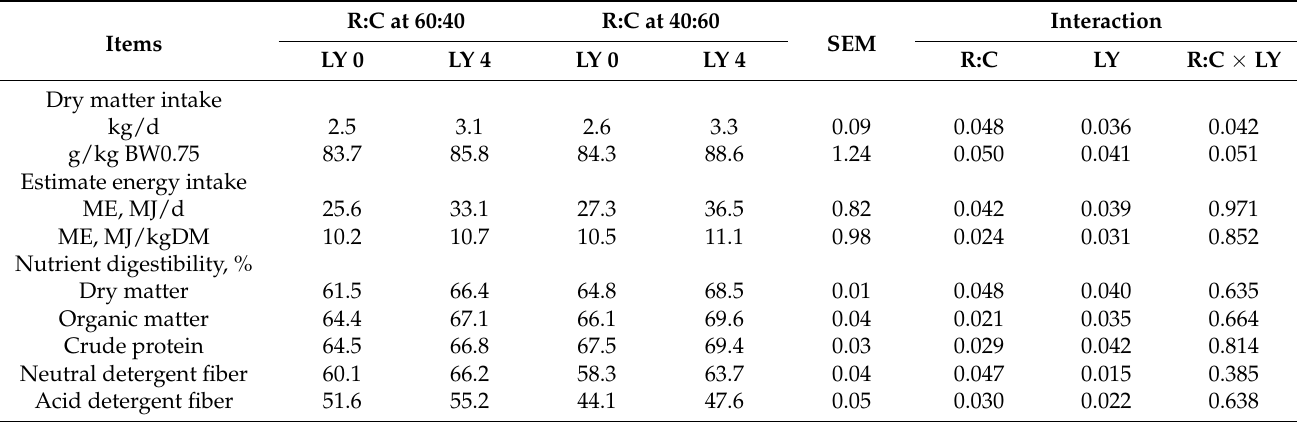
Table 2. Effect of roughage-to-concentrate ratio and live yeast supplementation on voluntary feed intake and nutrient digestibility in Thai native beef cattle.